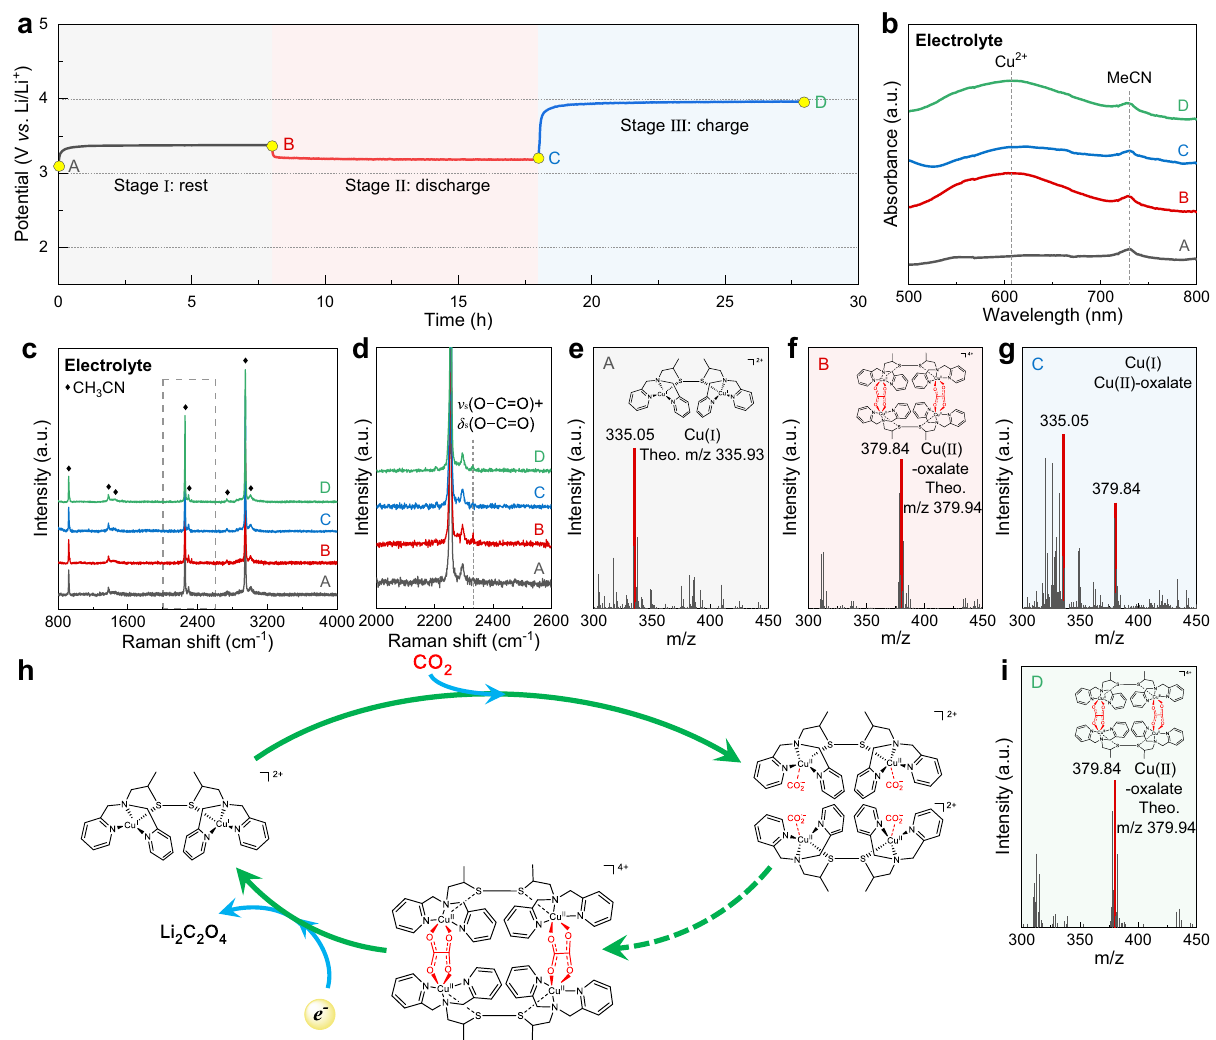
Fig. 3 | Electrolyte characterization of Li – CO 2 batteries with Cu(I) RM-based electrolyte. a Discharge-charge curve of the Li – CO 2 battery with the addition of Cu(I) RM, showing three stages, namely rest, discharge, and charge. b UV – Vis and c Raman spectra of Cu(I) RM-based electrolytes in the Li – CO 2 battery at different